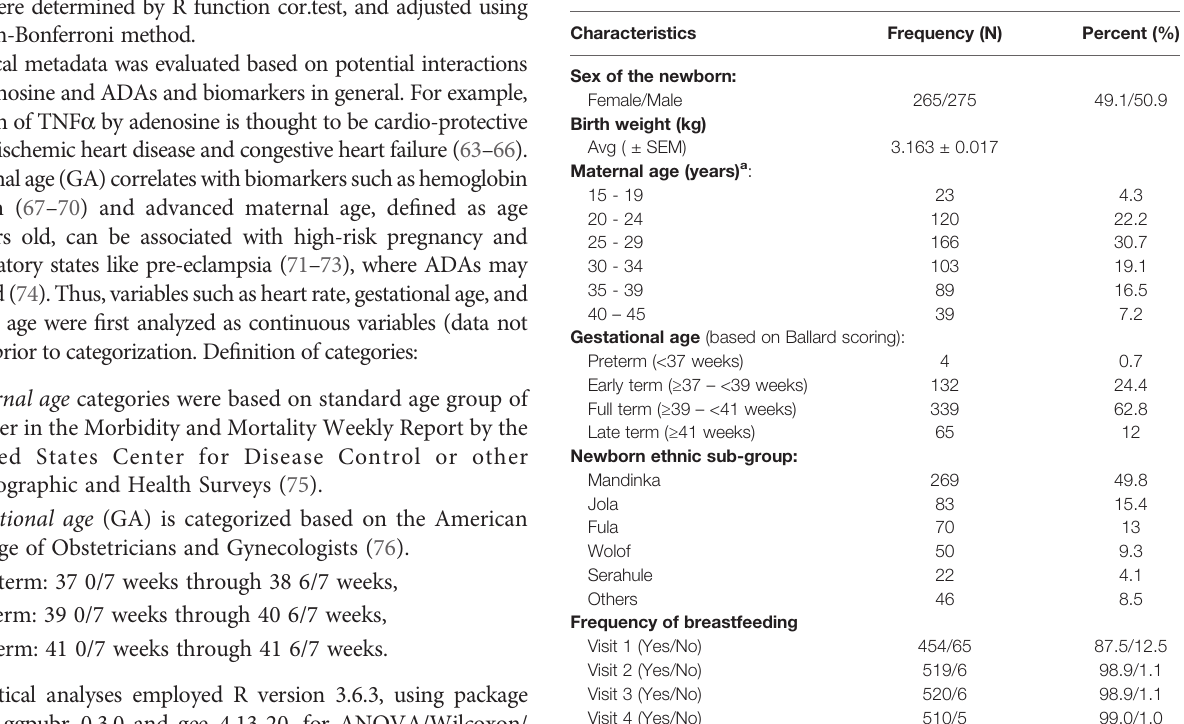
TABLE 1 | Characteristics of EPIC002 study